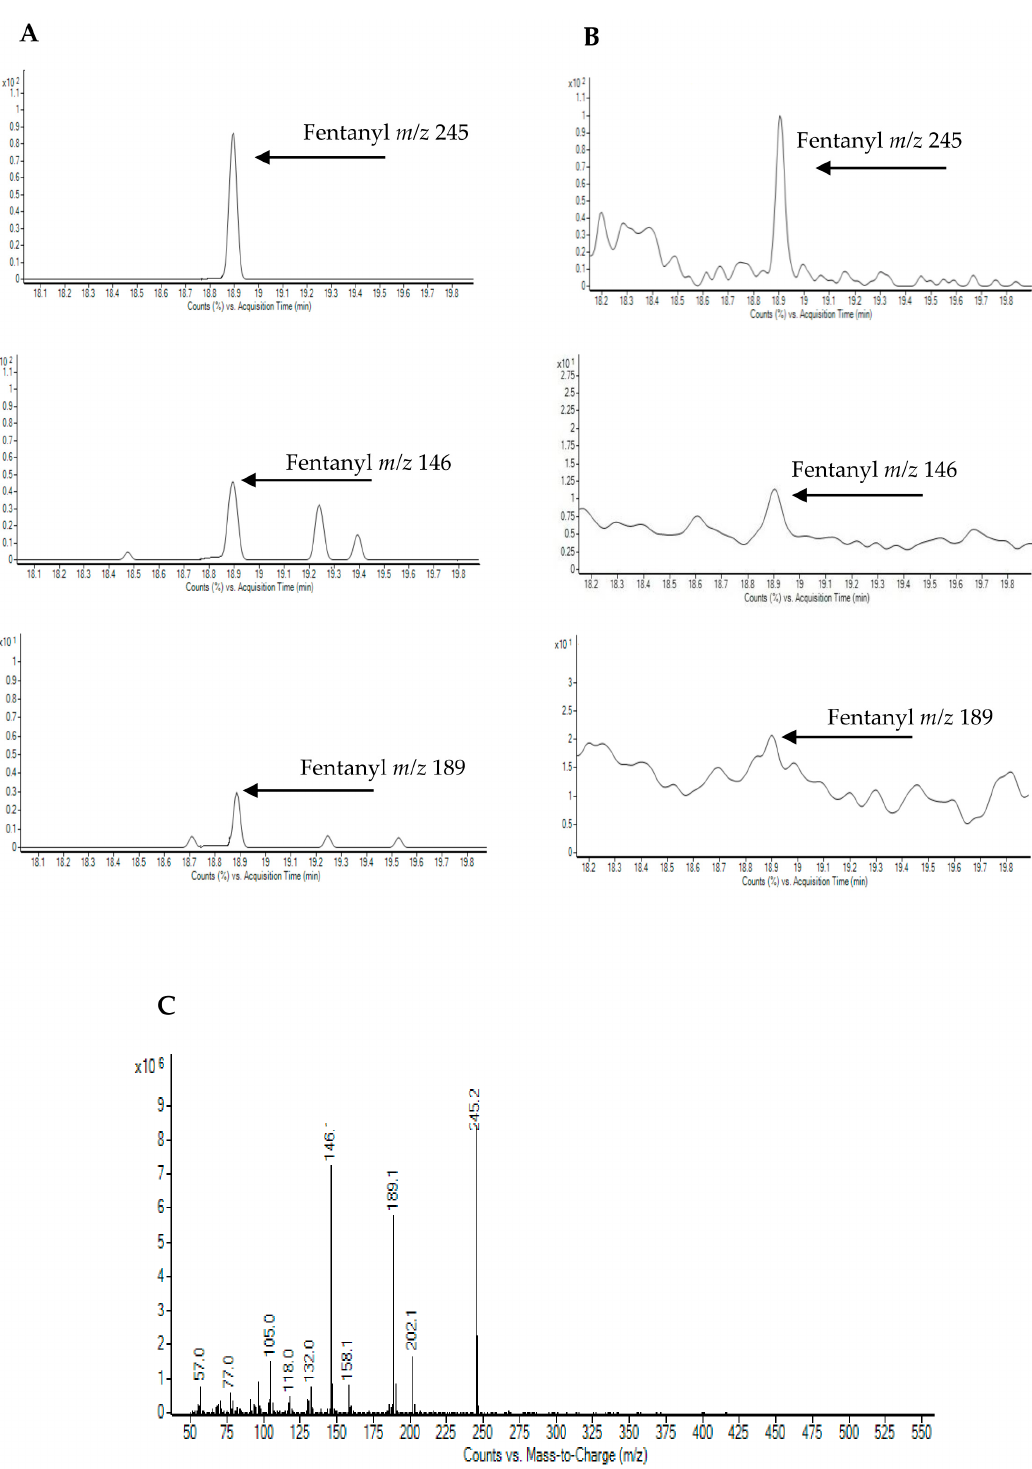
Figure 2. Representative selected ion monitoring GC-MS chromatograms of: urine samples positive to Fentanyl ( A , B ) and mass spectrometry or tandem mass spectrometry (MS/MS) full scan mass spectrum used for substance identification ( C ).